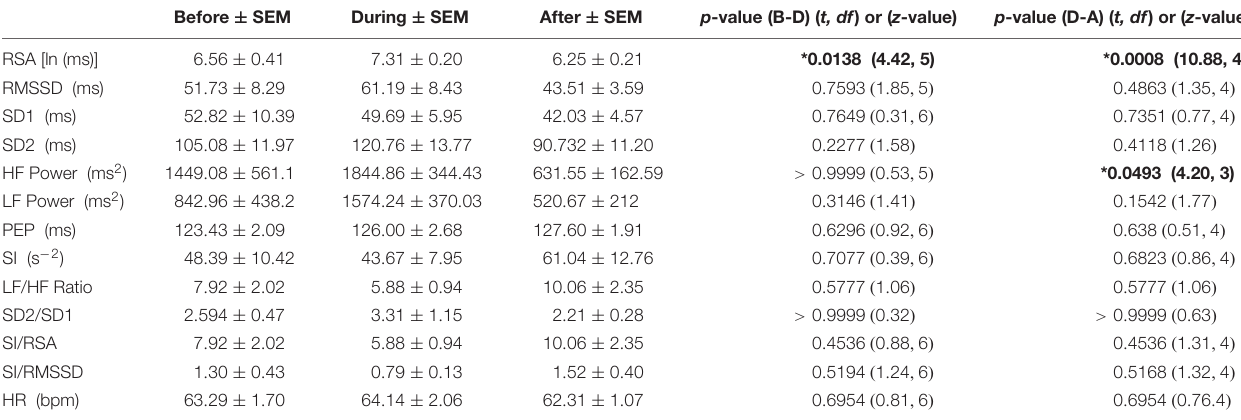
TABLE 3E | HRV parameters associated with HAPWs in response to distal balloon distention ( n = 7). Before ± SEM During ± SEM After ± SEM